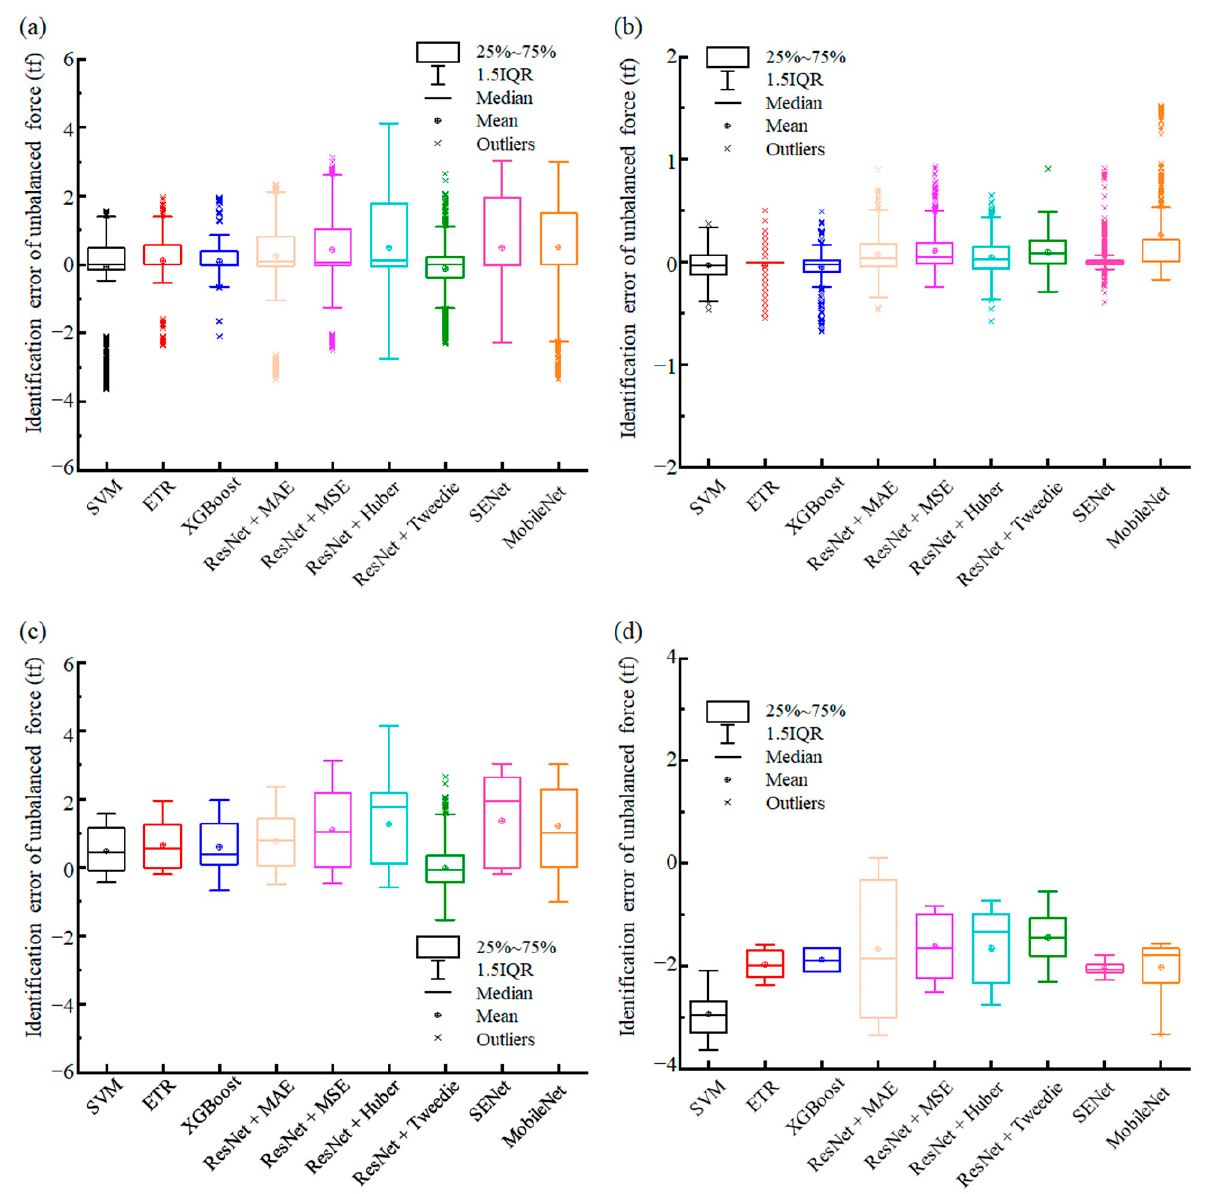
Figure 9. The identification error of each model’s test dataset. ( a ) Entire test dataset; ( b ) Many-shot region; ( c ) Few-shot region; ( d ) Missing-shot region.